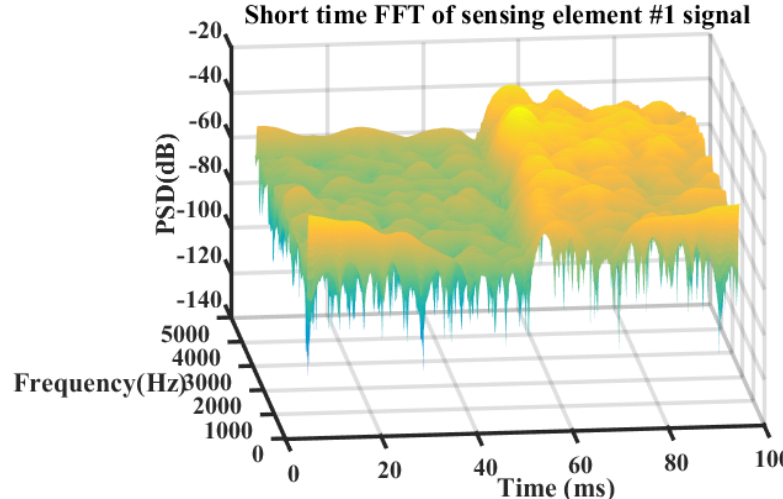
Figure 11. Short time FFT spectra of the detected signal acquired by sensing element #1 at a pulse repetition rate of 10 kHz.